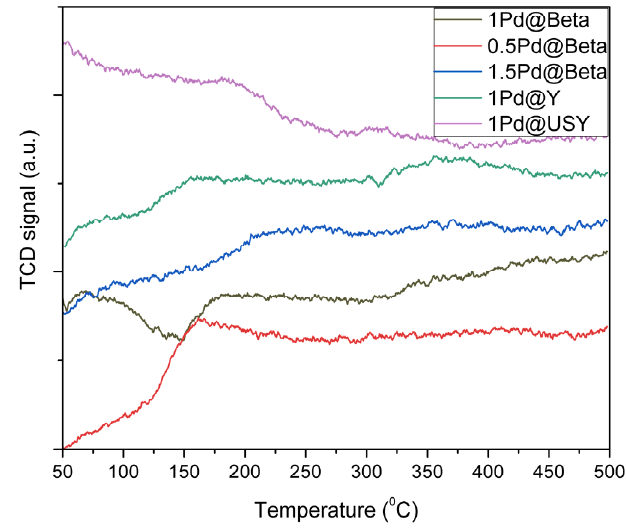
Figure 7. H 2 ‐ TPR profiles for Pd@zeolite samples. Figure 7. H 2 -TPR profiles for Pd@zeolite samples.